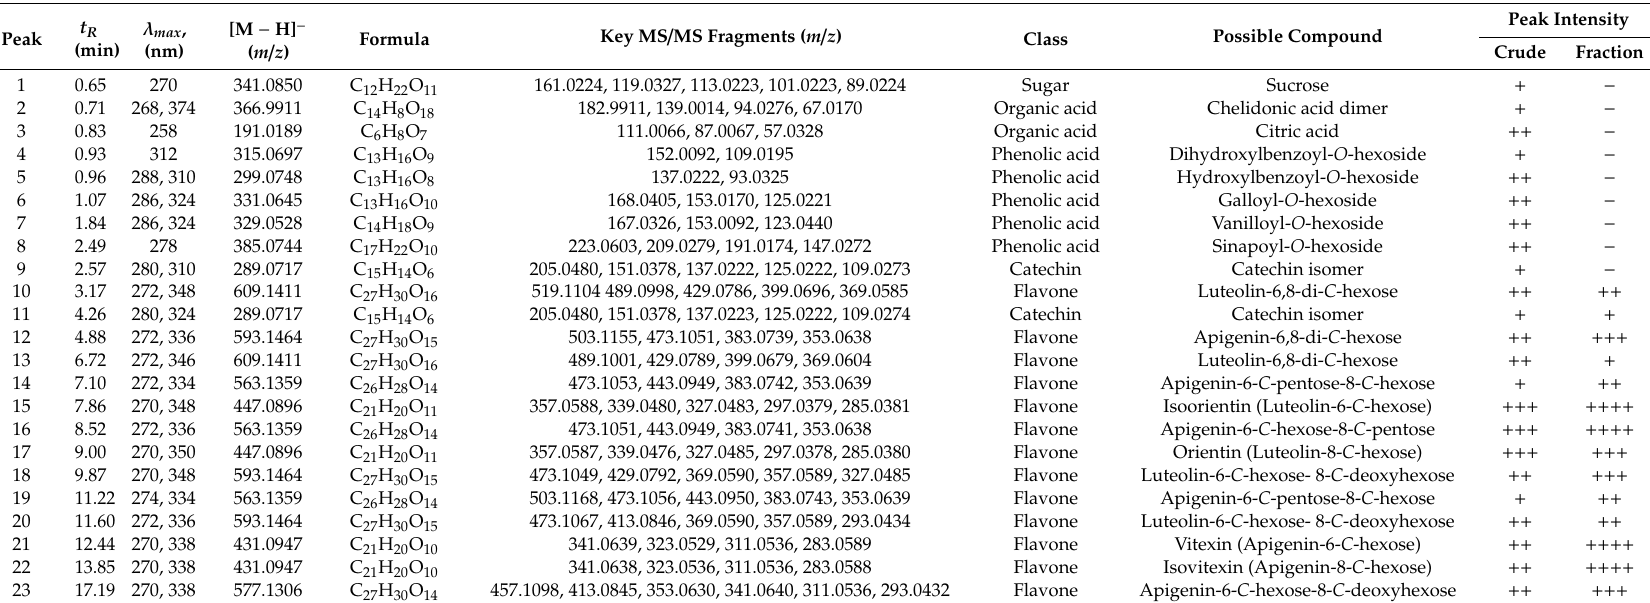
Table 3. Putative identification of compounds present in crude extract and enriched fraction using UHPLC–UV / PDA and UHPLC–MS / MS